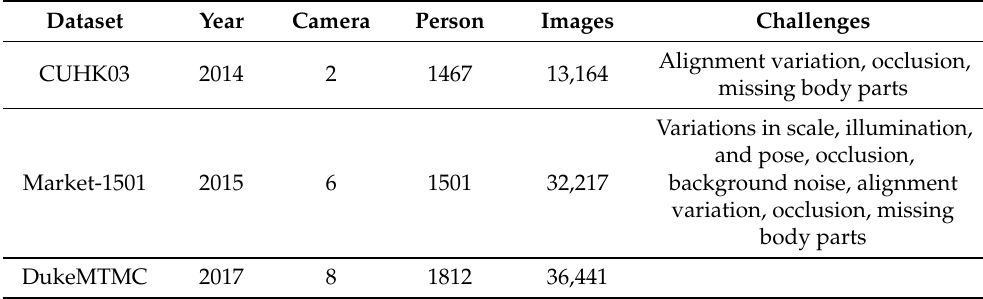
Table 2. Description of the employed datasets in this